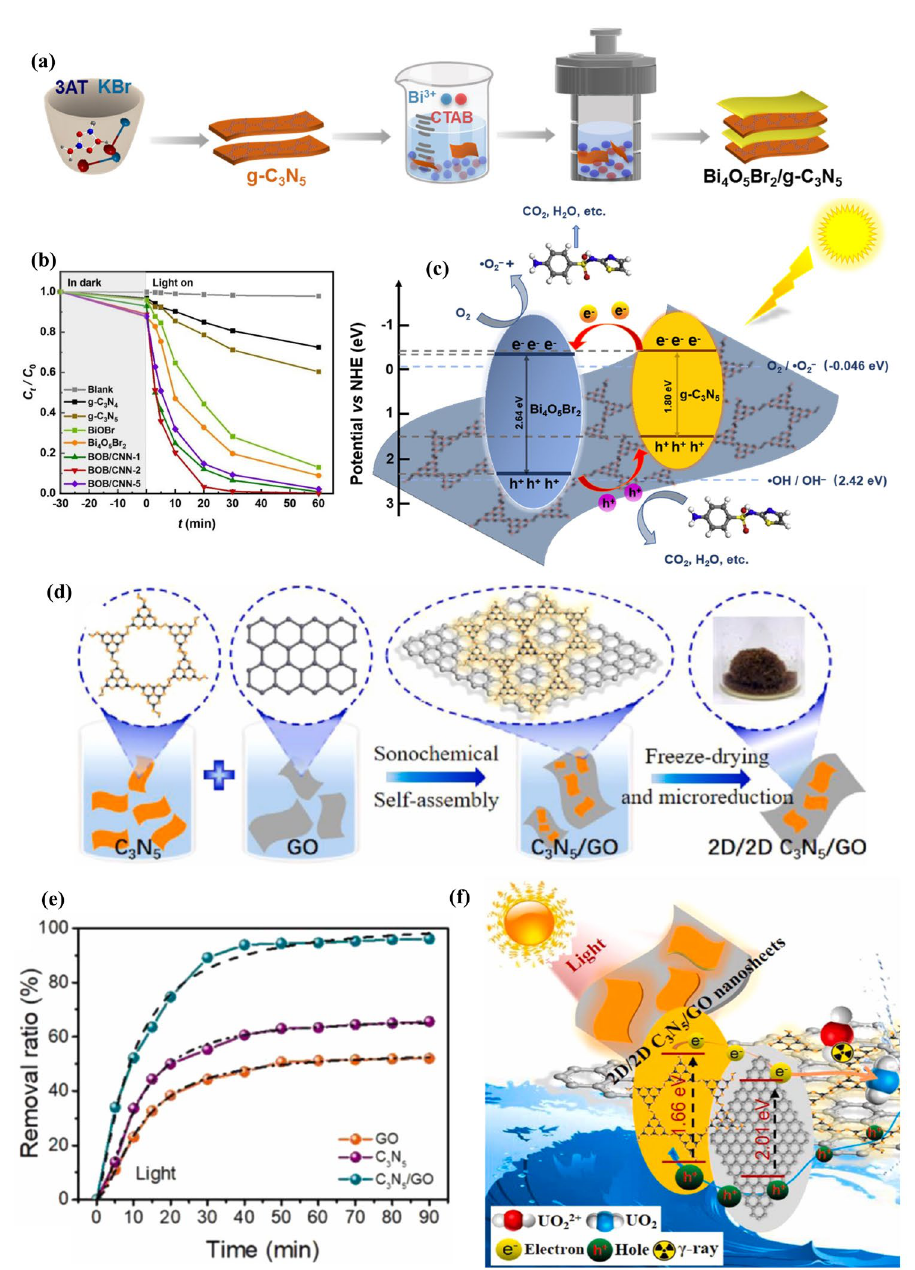
Figure 12. ( a ) g-C 3 N 5 /Bi 4 O 5 Br 2 preparation routes; ( b ) Photocatalytic degradation of STZ by g- C 3 N 5 /Bi 4 O 5 Br 2 ; ( c ) Photoreaction mechanism of STZ by g-C 3 N 5 /Bi 4 O 5 Br 2 ; ( d ) Diagram of the g- C 3 N 5 /GO preparation; ( e ) U(VI) removal ratio; ( f ) Mechanism schematic of U (VI) extraction